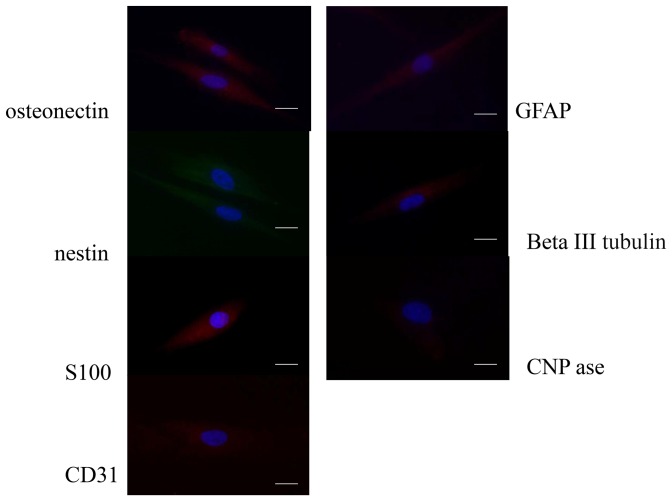
Immunofluorescence analyses of human fibroblasts (used as control).Bar: 30 µm.